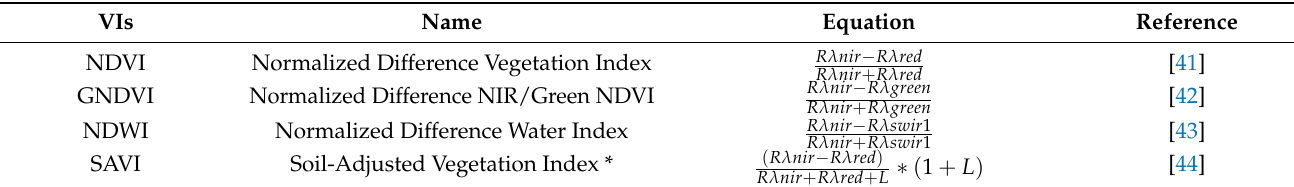
Table 3. Spectral vegetation indices (VIs) used in the